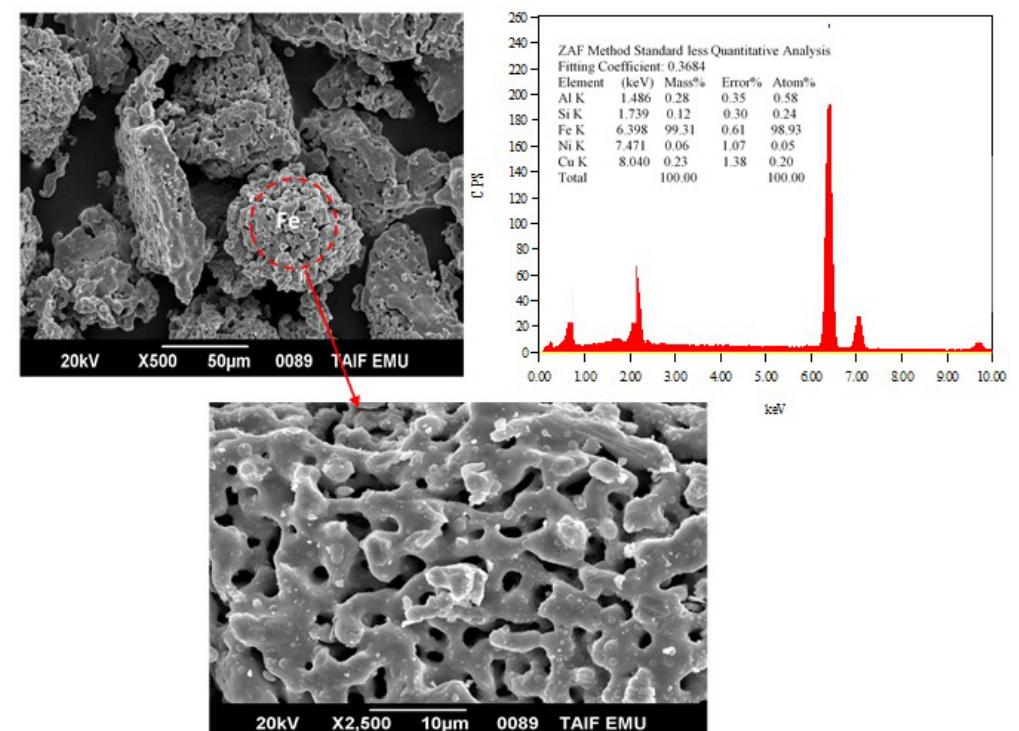
Figure 10. SEM image and correspondent “EDS” spectrum analysis of reduced iron powder at 1000 o C in H